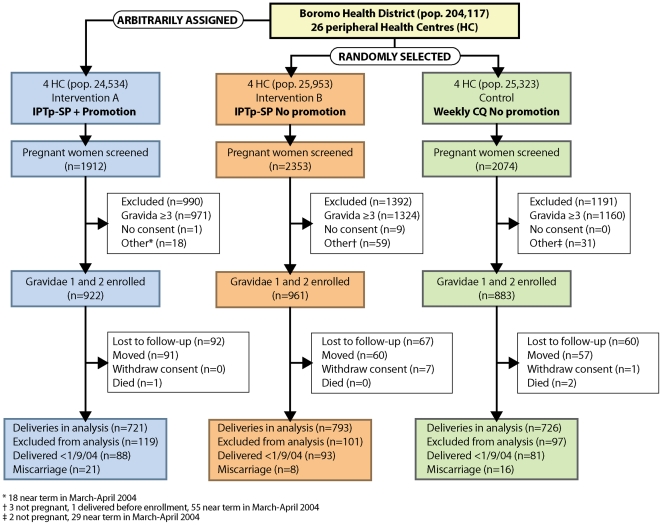
Trial participant flow diagram.